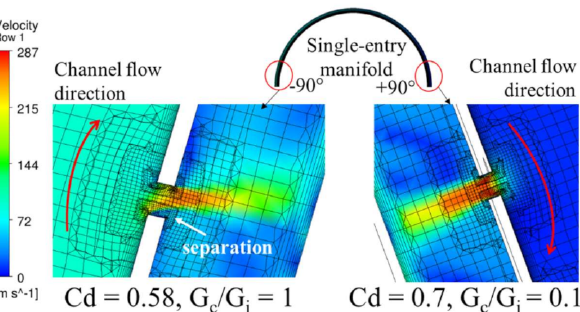
Figure 13. Cross–section of aero–field through Row 1 holes near − 90 ◦ and +90 ◦ for single–entry case. The 50% and 20% mass flow rate conditions show similar trends for the HTCs in Figures 14 and 15, with lower absolute levels due to the reduced mass flow rates. For the single-entry case, there are now three peaks instead of four, suggesting that the Reynolds number of the manifold channel affects the formation of the secondary flow features. The HTC delivered by the multiple-entry system is similar in value to the single-entry system between − 90 ◦ and − 20 ◦ , while the sector from 0 ◦ to 45 ◦ sees a large drop in HTC values. This is likely due to this sector being upstream of the 45 ◦ –90 ◦ sector, but is fed by the same transfer box. Hence, the flow exiting the 45 ◦ transfer box not only has decreased total pressure due to frictional losses in the ring main, but now has to work against the forward momentum to deliver mass flow to the upstream sector.